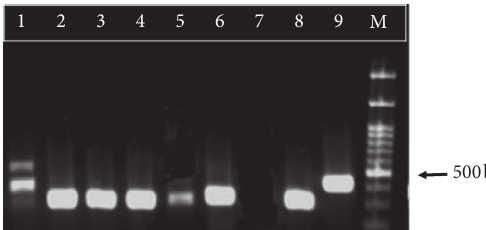
Figure 1: PCR product electrophoresis for ITS1 fragments of Leishmania from asymptomatic children on 1.5% agarose gel. Lane 1–6: isolated samples from asymptomatic children; lane 7: negative control; lane 8: L. infantum positive control; lane 9: L. tropica positive control; and lane M: 1 kb molecular weight marker.